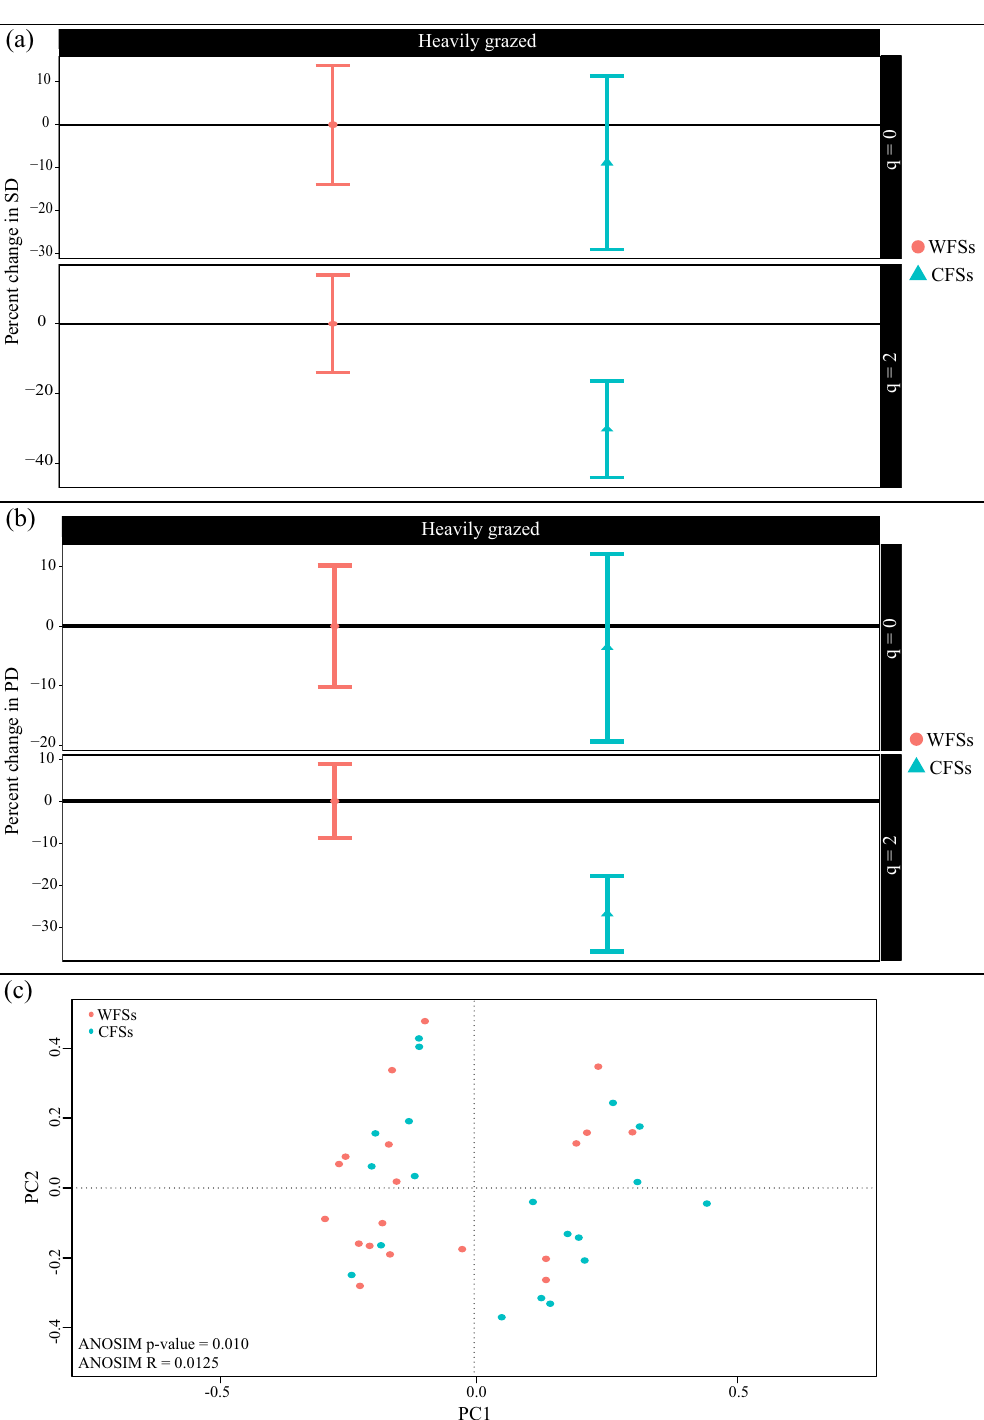
Figure 5. The coverage-based comparison of ( a ) species and ( b ) phylogenetic diversity of communities containing (CFSs) and without (WFSs) Seseli transcaucasicum . ( c ) Transformation-based principal component analysis and analysis of similarity (ANOSIM) results showing the species composition differences in CFSs and